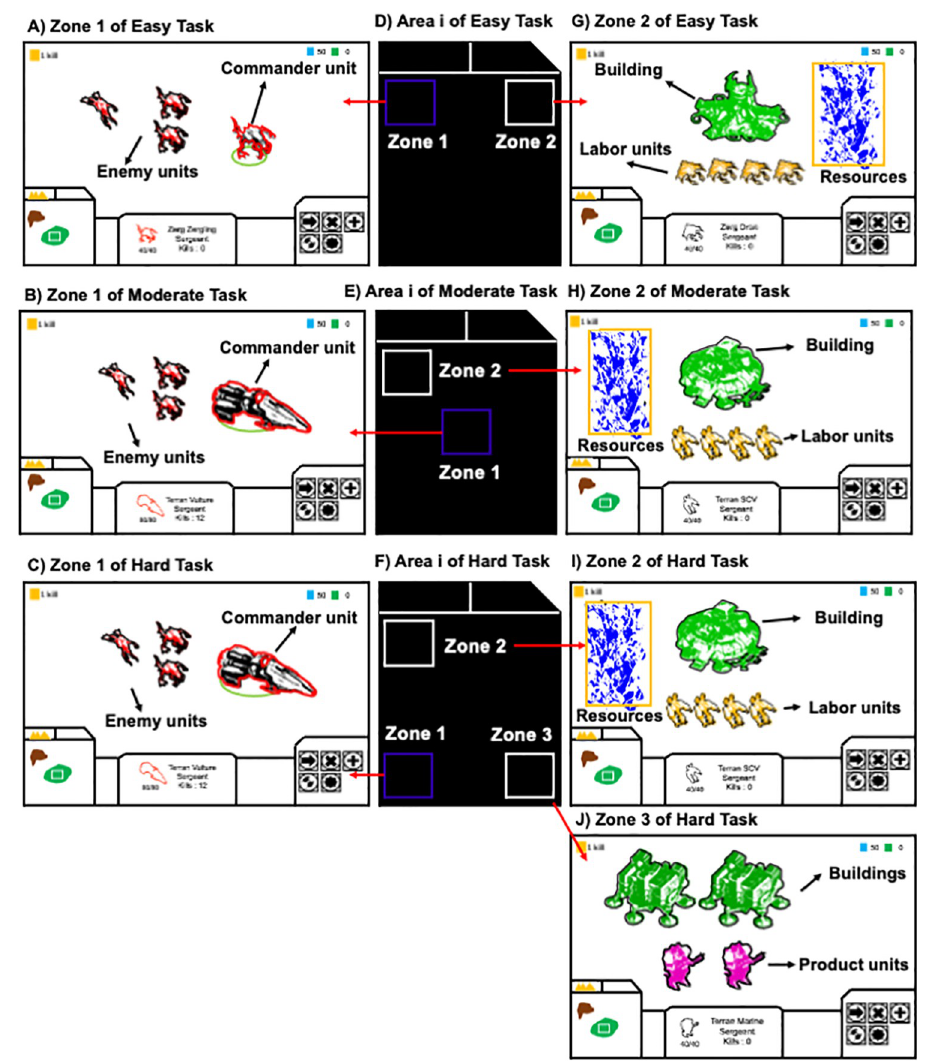
Fig 3. Three different types of task-switching activities. The meaning of each box is as follows. white boxes: Collecting resources and constructing buildings are done in these zones (Zone 2 and Zone 3). Blue box: The battle between the commander unit and enemy units occurs in this zone (Zone 1). Yellow box: